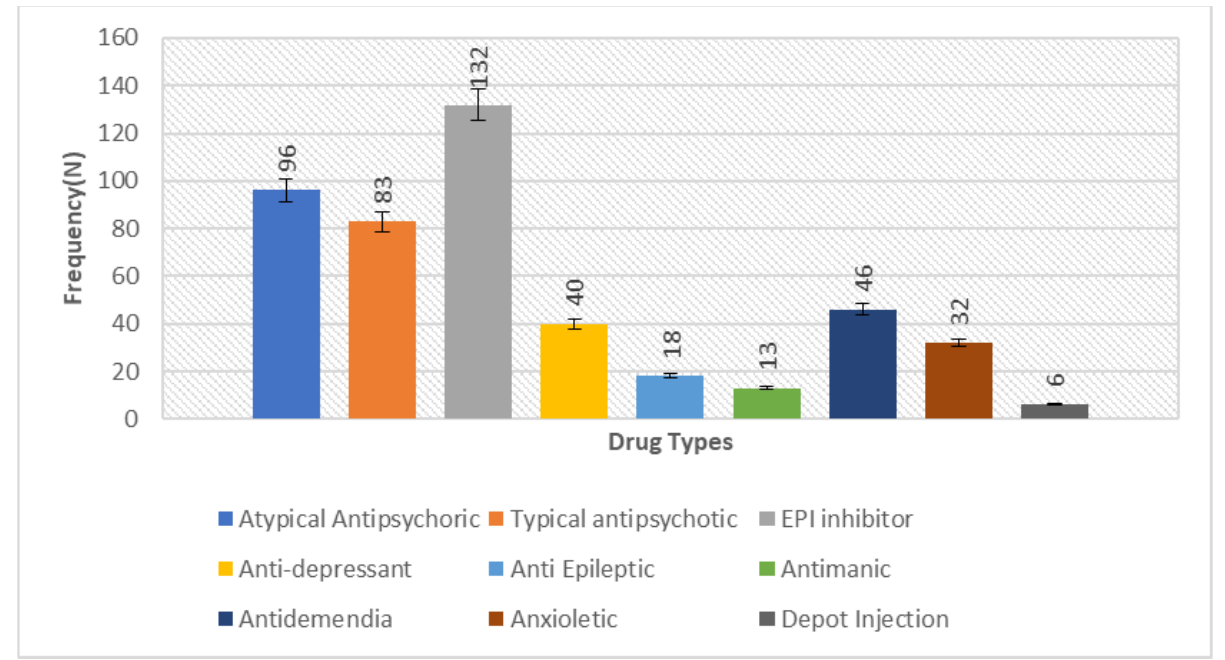
Figure 3. Bar chart depicting the measure of prescription frequency of drugs in the studied sample of 200 schizophrenia patients, representing the comparative higher frequency of antipsychotics (typical 96 and atypical 83) to lower the severity of symptoms in the disorder.